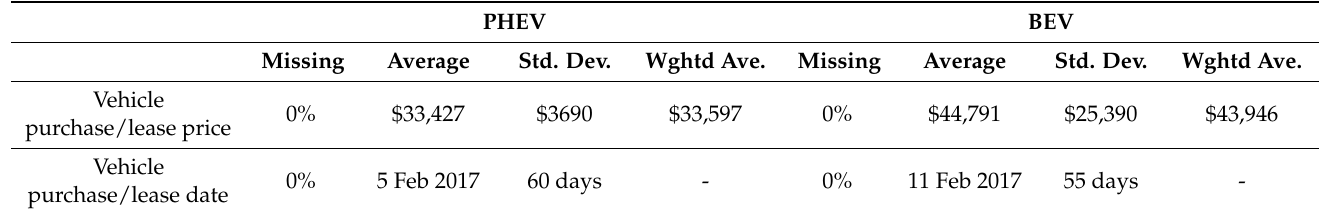
Table 3. Ratio and Interval Variable Data